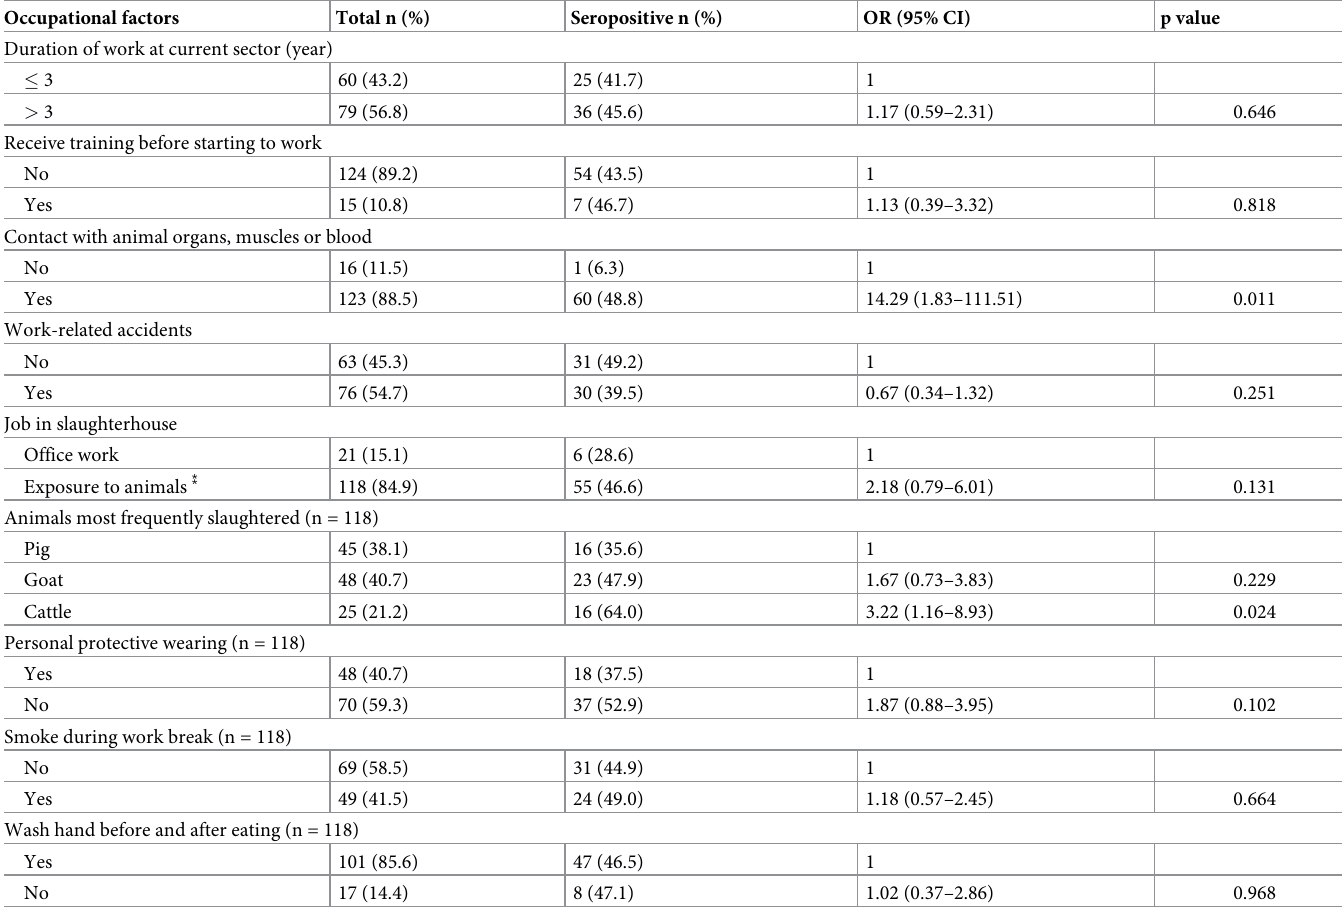
Table 3. Occupational factors associated with seropositivity of Toxoplasma gondii among slaughterhouse